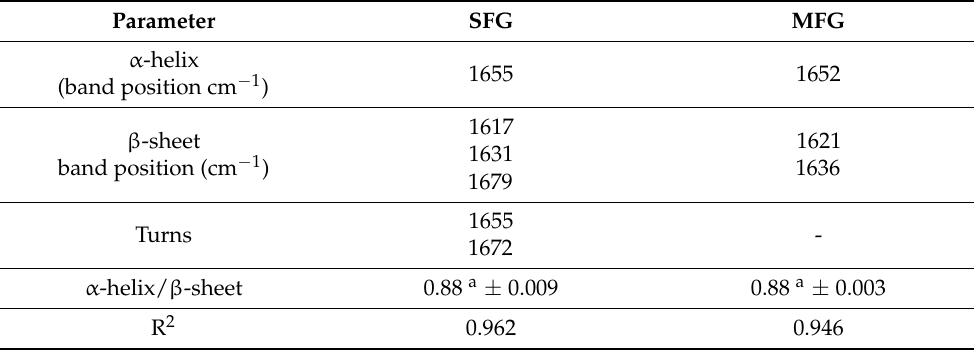
Table 6. Assignment of secondary structure to the Gaussian curves obtained from amide I peak through FTIR analysis of SFG and